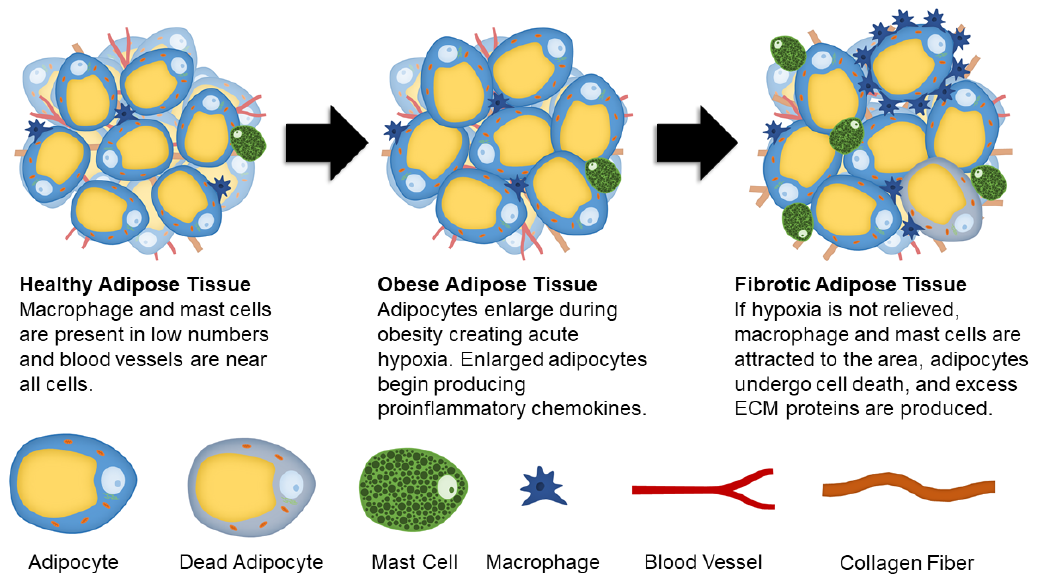
Figure 1. Schematic showing changes to adipose tissue during obesity and fibrosis development.